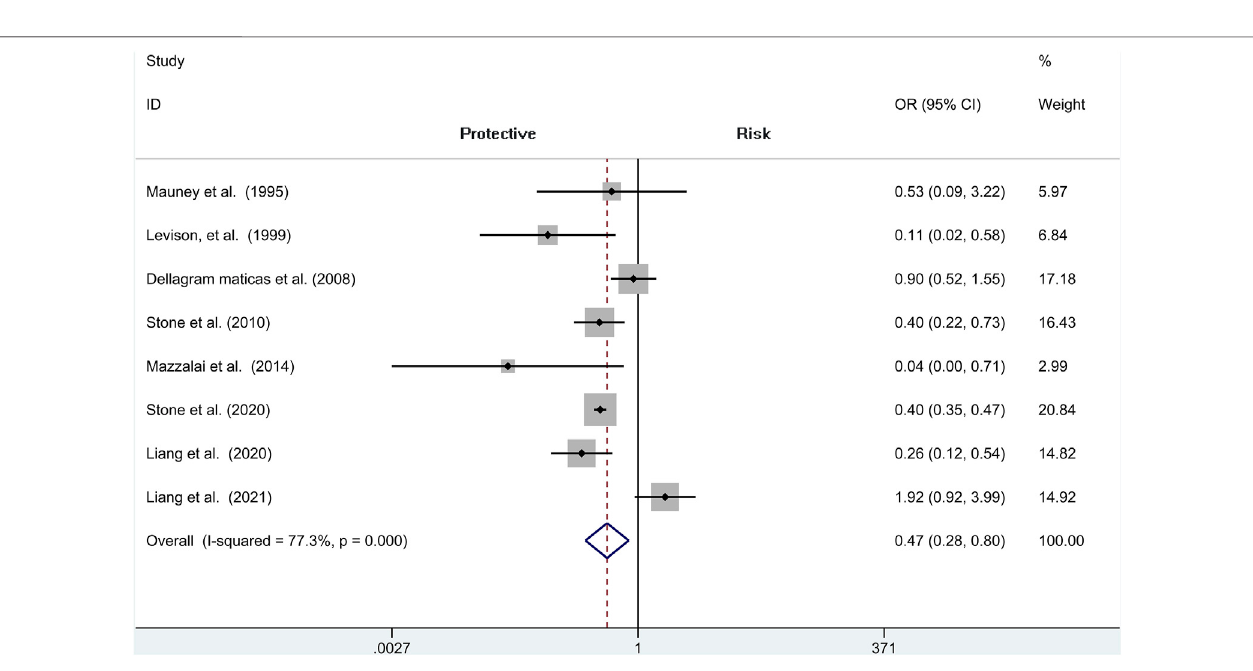
Frontiers in Pharmacology |